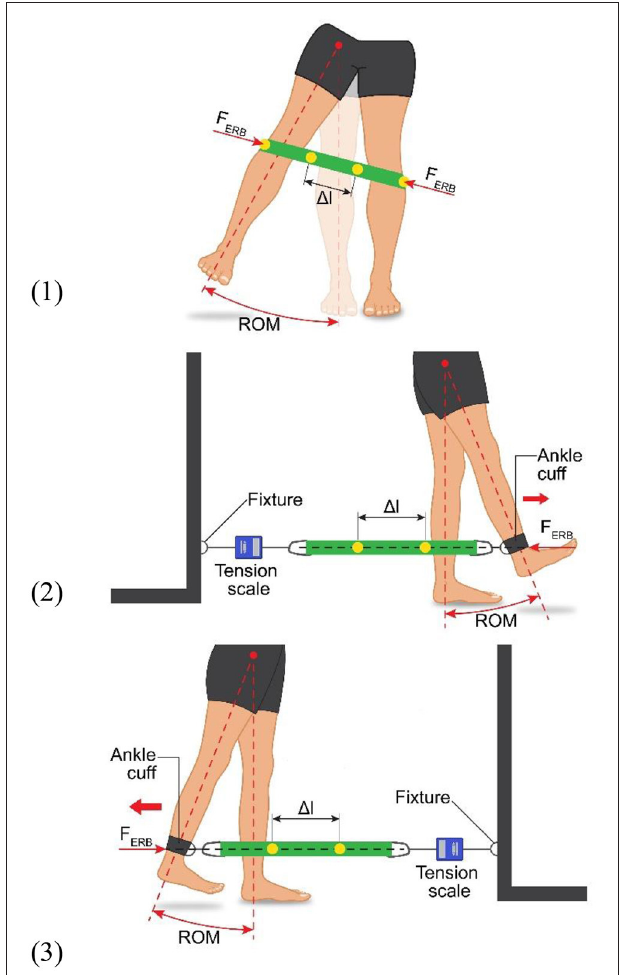
FIGURE 1 | Experimental setup showing the movement execution, as well as showing the elastic resistance band (ERB) fastening method and position for all three exercises: (1) standing single-leg abduction, (2) standing single-leg hip extension, and (3) standing single-leg hip flexion. The dimension 1 l shows the measured marker displacement used to calculate the force production of the ERB (i.e., F ERB ).